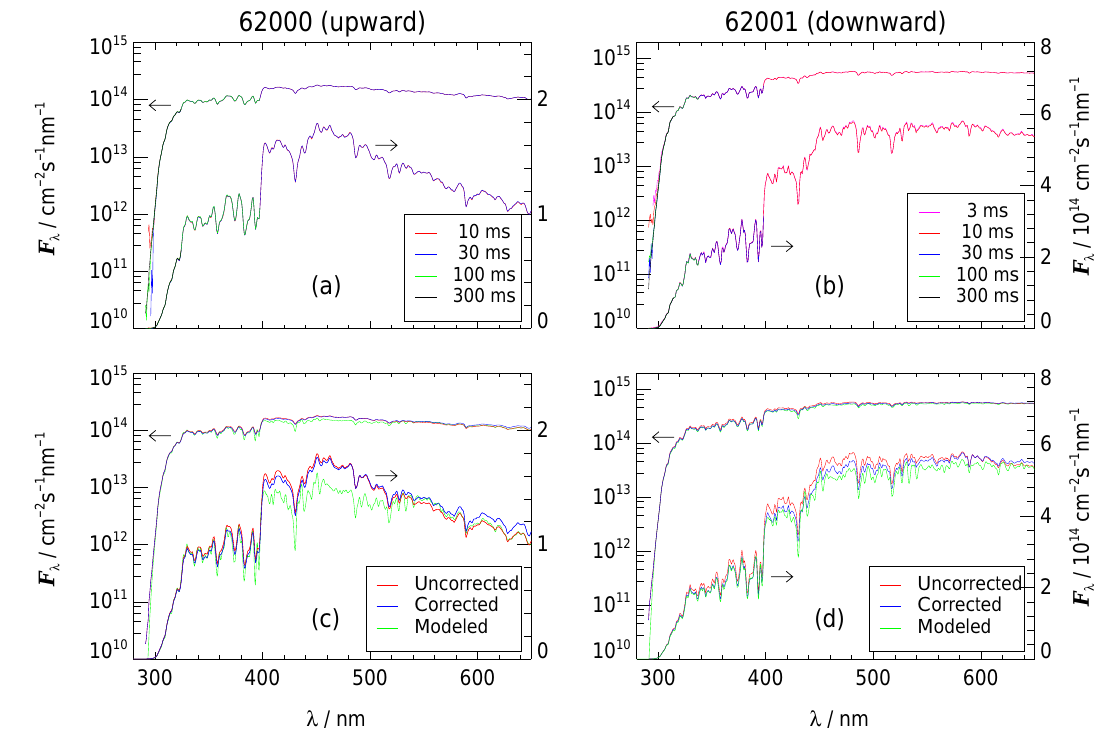
Figure 14. Evaluated upward (left) and downward (right) spectral actinic flux densities of the data shown in Fig. 13 in linear and semiloga- rithmic representations. Arrows point to the respective axes. In panels (a) and (b) spectra obtained with different integration times are plotted upon each other. Because for 30ms (a) and 10ms (b) no saturation occurred, the data shown for the shortest integration time in each panel were not used for the final optimization of spectra. In panels (c) and (d) the spectra denoted as uncorrected (red) represent the optimized spectra of panels (a) and (b) . Optical-receiver-specific corrections led to the slightly modified, corrected spectra (blue). Results of radiative transfer calculations for clear-sky conditions are denoted as modeled